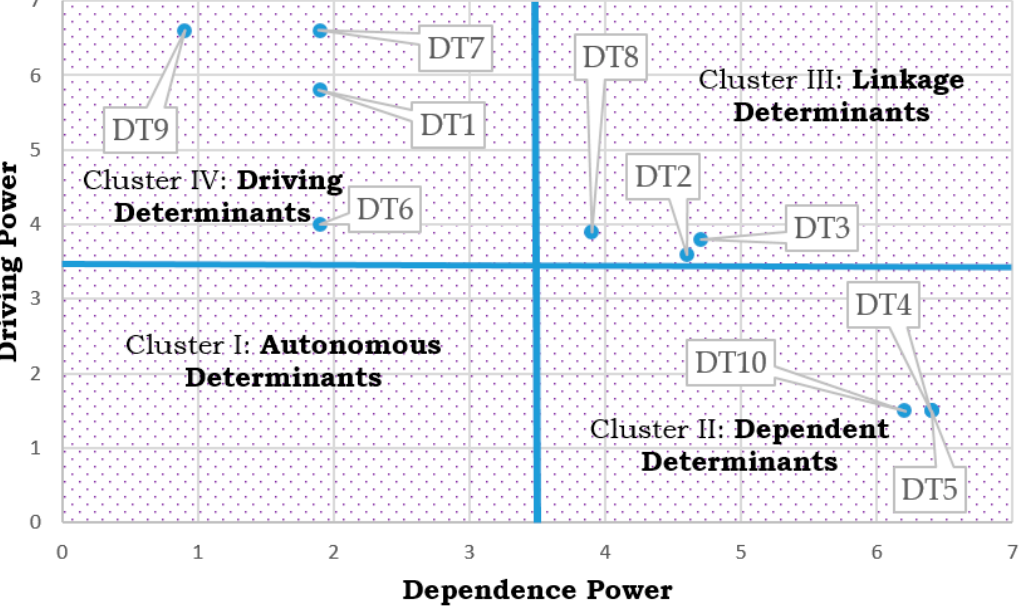
Figure 4. Fuzzy MICMAC analysis of determinants of Logistics 4.0.